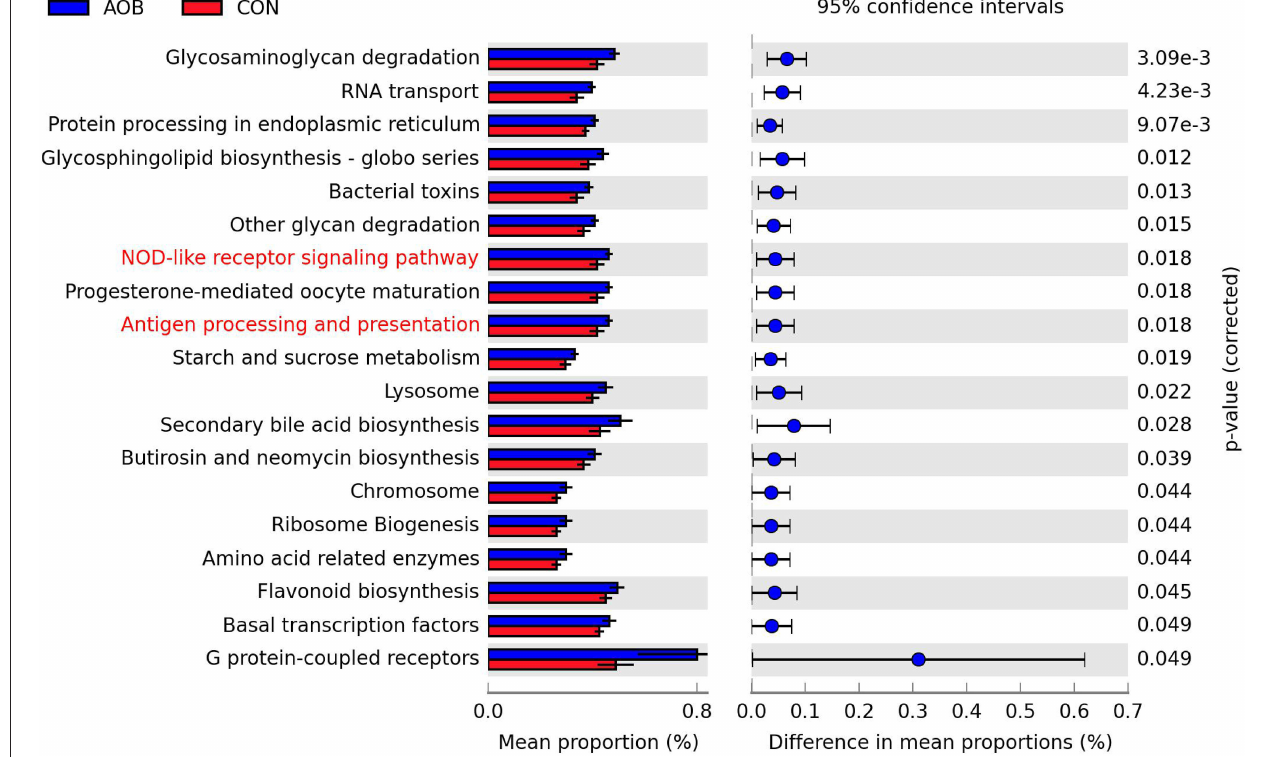
FIGURE 4 | Significantly different abundance of 19 KEGG pathways (level III) of predicted microbial functional composition from 16s rRNA sequencing data with PICRUSt between two groups ( n = 6). Highlight KEGG (Red) related to the metabolism (level I). The extended error bar plot was generated using STAMP software. Welch’s two-sided test with FDR correction, p < 0.05. KEGG, Kyoto encyclopedia of genes and